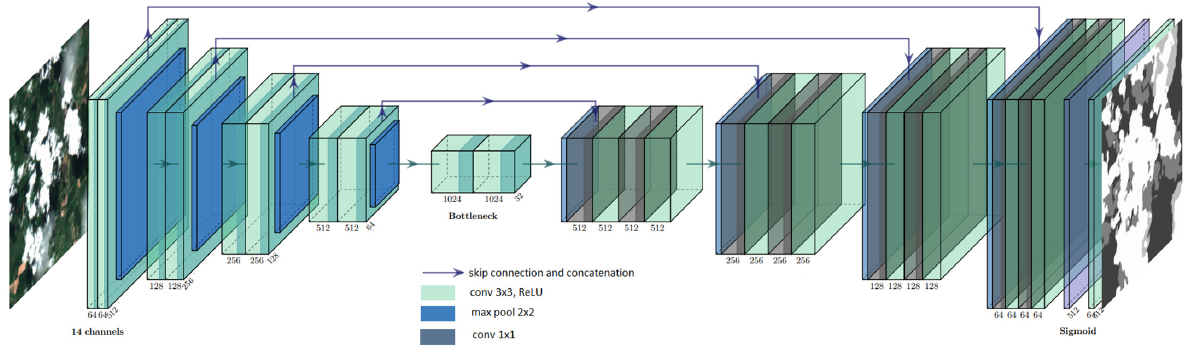
Figure 4. U-Net model architecture used for training.